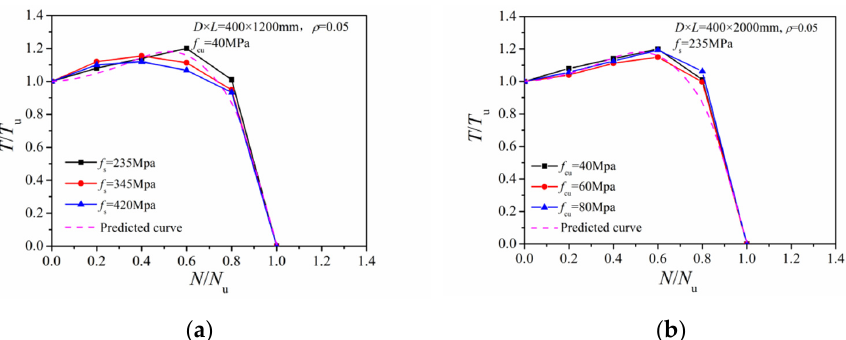
Figure 11. Effect of different steel and concrete strengths: ( a ) Steel yield strength; ( b ) concrete strength.